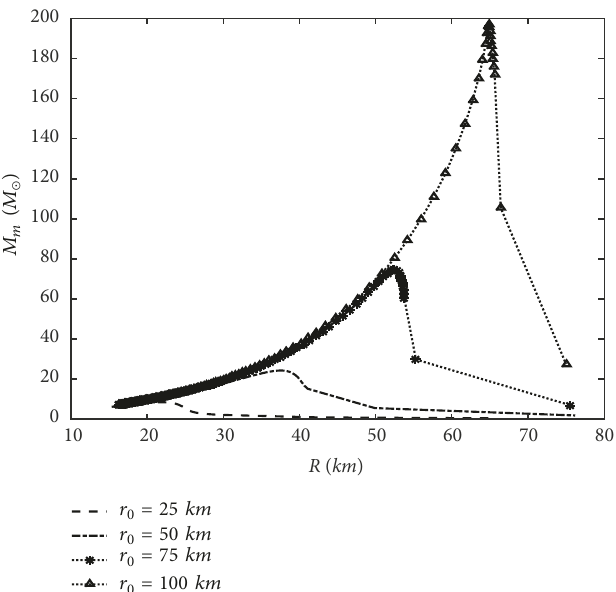
Figure 9: The mass of a star as a function on its radius 𝑅 . With the modified coupling of the dark-energy to the mass density the maximal mass possible is now about 200. The figure is taken from